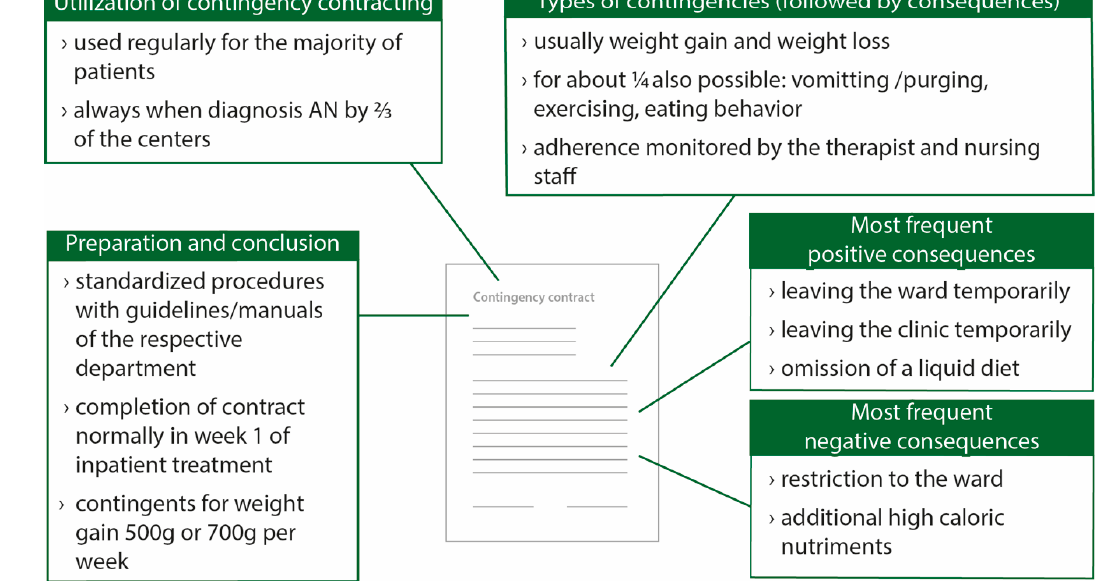
Figure 2. Characteristics of typical contingency contracts in specialized German university centers; AN = anorexia nervosa.